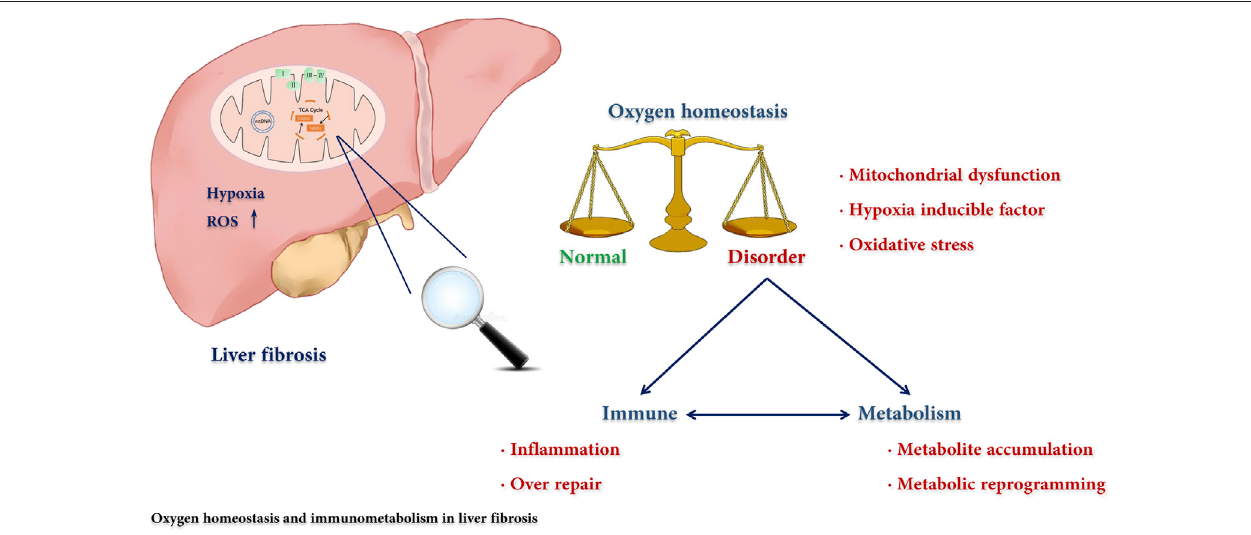
FIGURE 3 | The regulatory mechanism for immunometabolism and oxygen homeostasis in liver fi brosis. The disorders of immunity and metabolism are cross- linked in liver fi brosis and play a central role in the pathogenesis. We reviewed the effect of the destruction of oxygen homeostasis on liver fi brosis and described how oxygen participated in this process through affecting the immune-metabolism